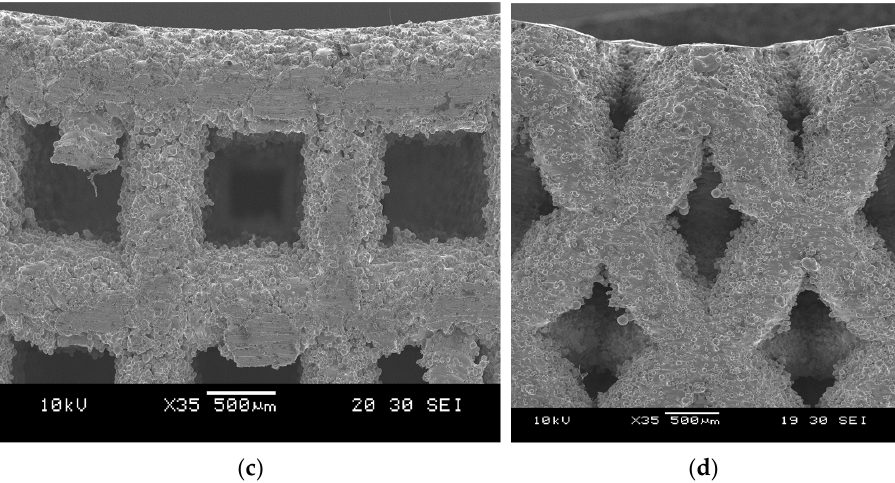
Figure 12. Bent specimens: ( a ) cubic (optical microscope), ( b ) diagonal (optical microscope), ( c ) cubic (SEM), and ( d ) diagonal (SEM).